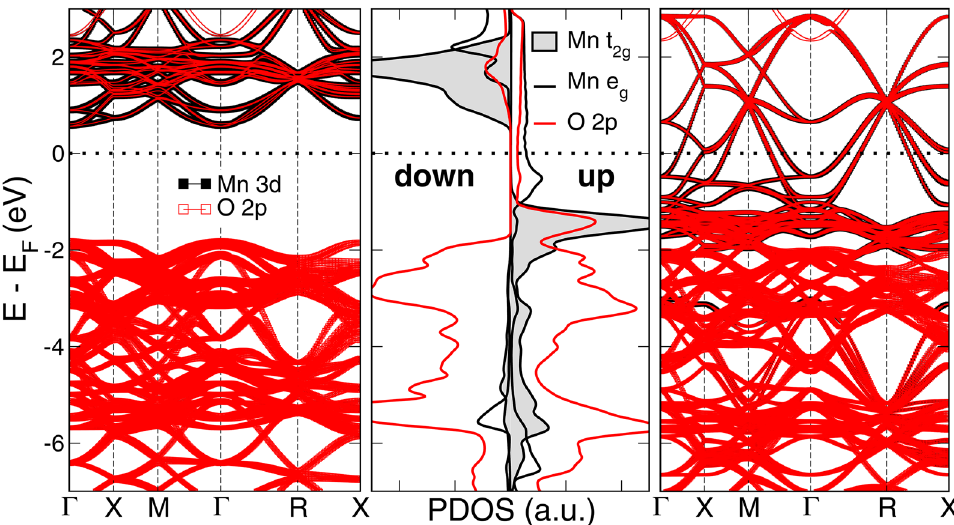
Figure 1. Electronic features of pristine LSMO. Left (Right) panels: Projected band structure for the spin down (up) channel for the Mn 3d and O 2p levels. Central panel: Partial Density of States (PDOS) highlighting the Mn t 2g and the Mn e g contributions to the Mn 3d states (spin down/up corresponds to the left/right side of this panel, denoted by bold labels).